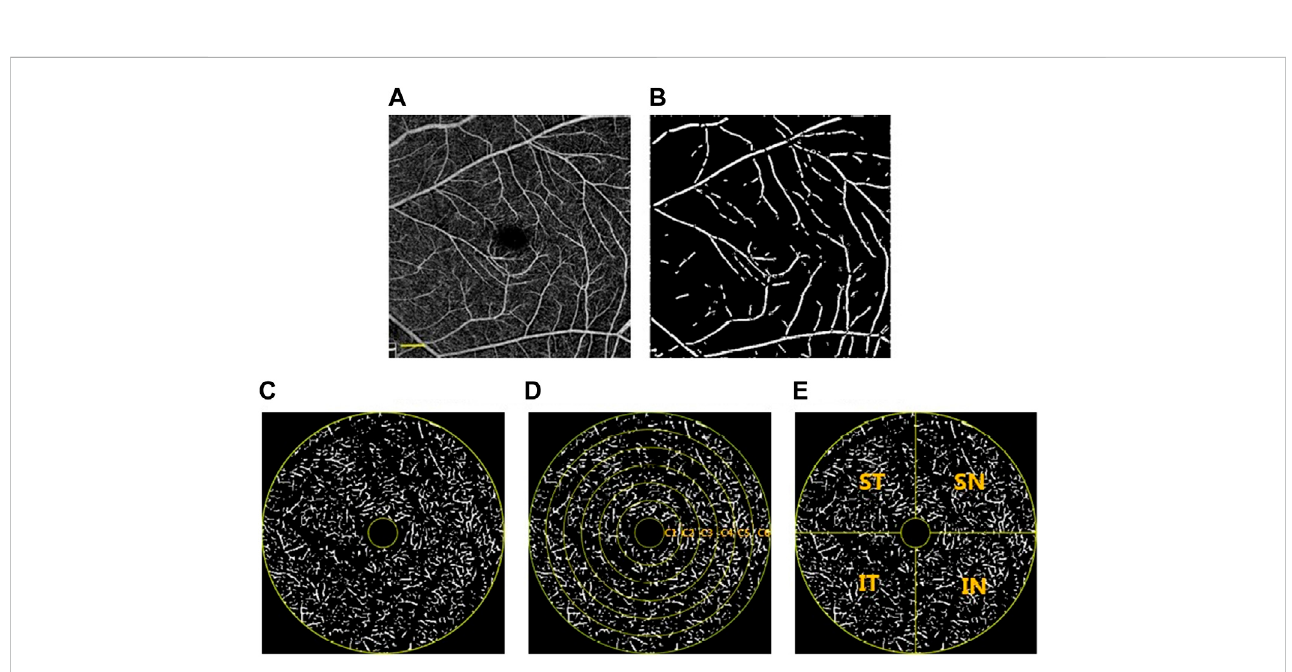
FIGURE 2 Image partitioning and processing methods. (A) OCTA image after magni fi cation correction. The OCTA image was skeletonized and large blood vessels withadiameter > 30 μ mwereextracted (B) anddivided.Theannularzonewithadiameterof0.6 – 5 mm (C) wasdividedinto6annuli(C1 — C6)foranalysisafter the removal of the avascular zone (D) . In addition, four quadrants centered on the fovea were generated (E) . ST, superior temporal; SN, superior nasal; IN, inferiornasal;IT,inferiortemporal.Scalebar:600 μ m. (A) , (B) , (C) , (D) ,and (E) werebasedonthesameOCTAimage,which wasthesamesampleasused for Figure